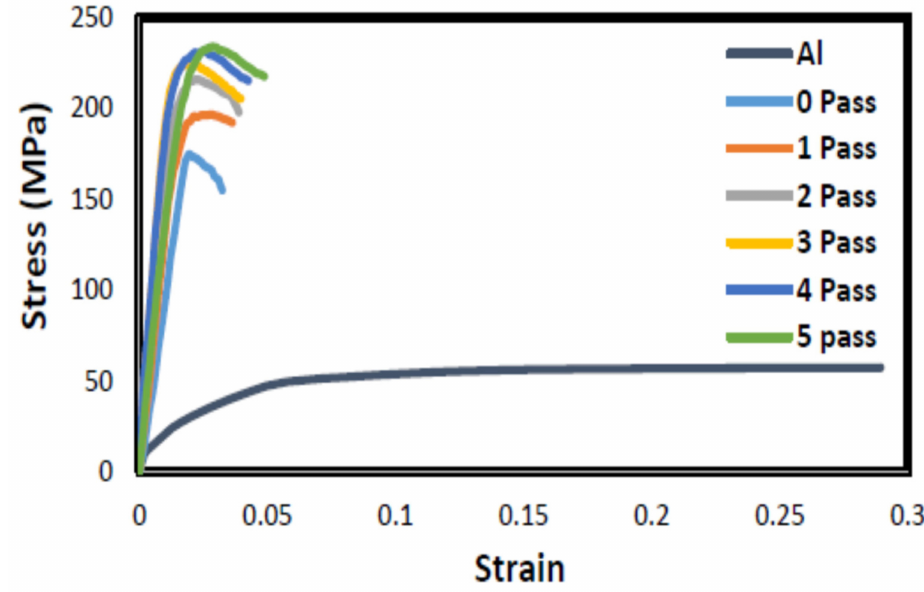
Figure 9. Stress–strain curves of Al and Al/4%SiC composite produced by the ARB process at various passes.